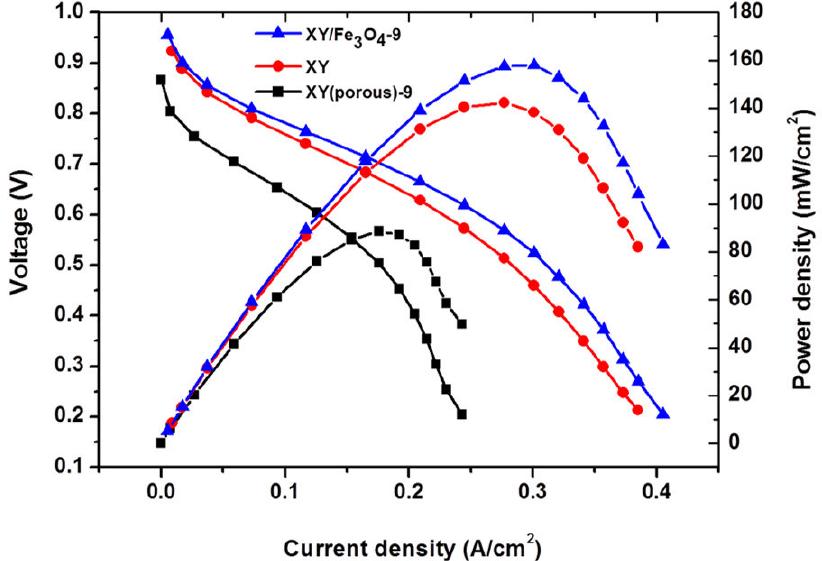
Figure 12. Polymer electrolyte fuel cell (PEFC) performance of the bare XY, composite, and porous